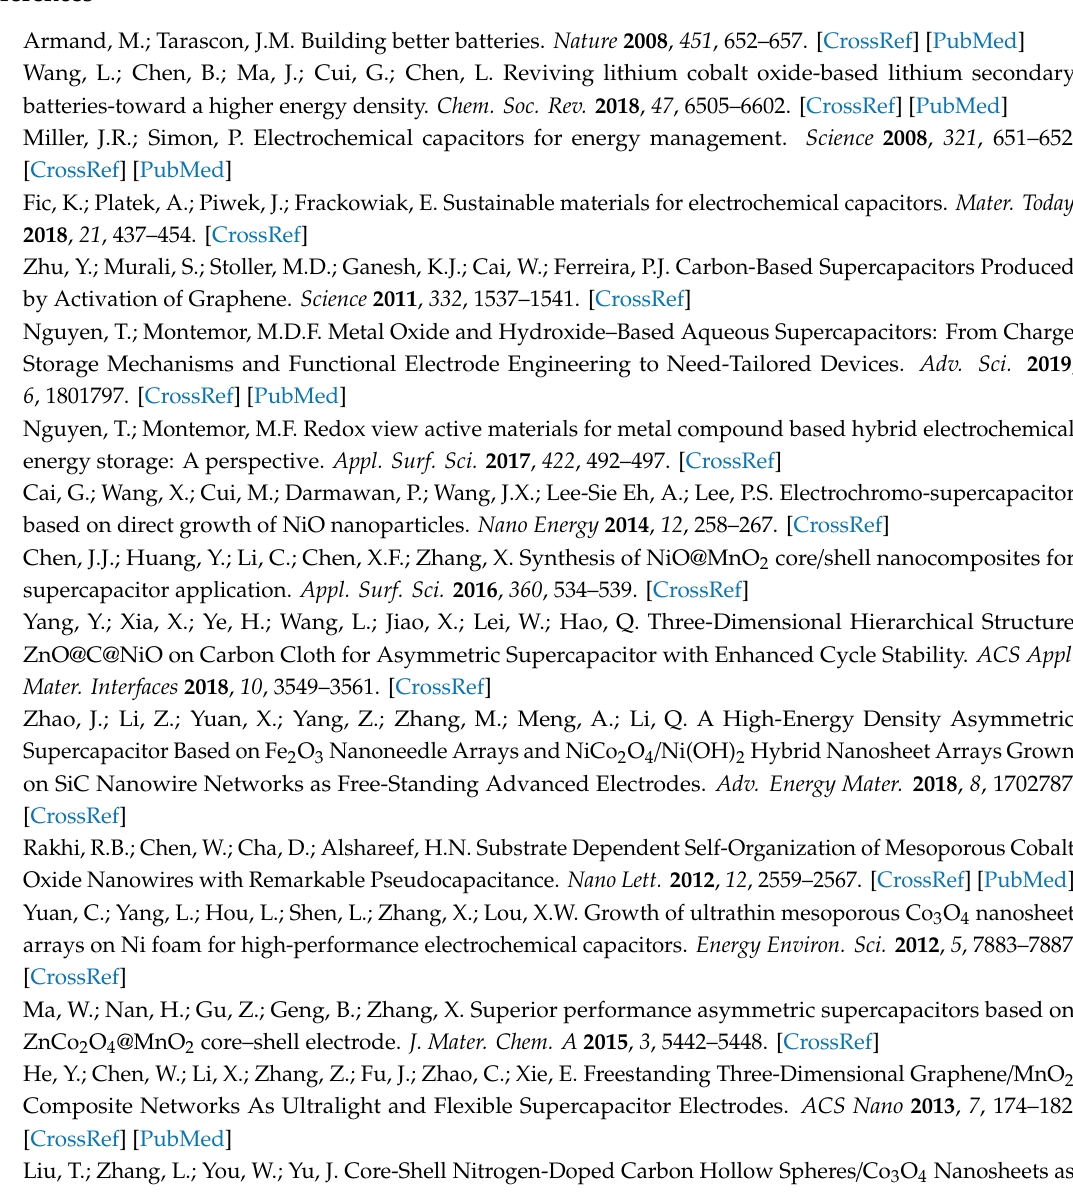
Figure S1: The XPS spectra of Ni-Co sulfide. (a) Ni 2p, (b) Co 2p, (c) S 2p, Figure S2: STEM–HAADF image and